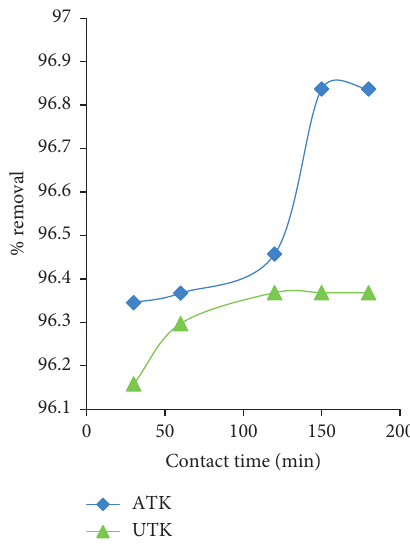
Figure 7: % removal of Cr (VI) ions versus contact time (mins).